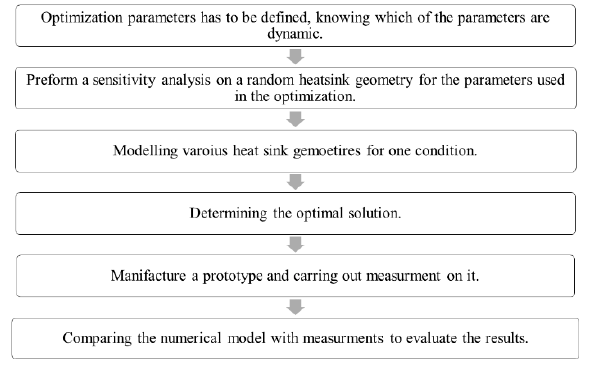
Figure 1. Method of the optimization.